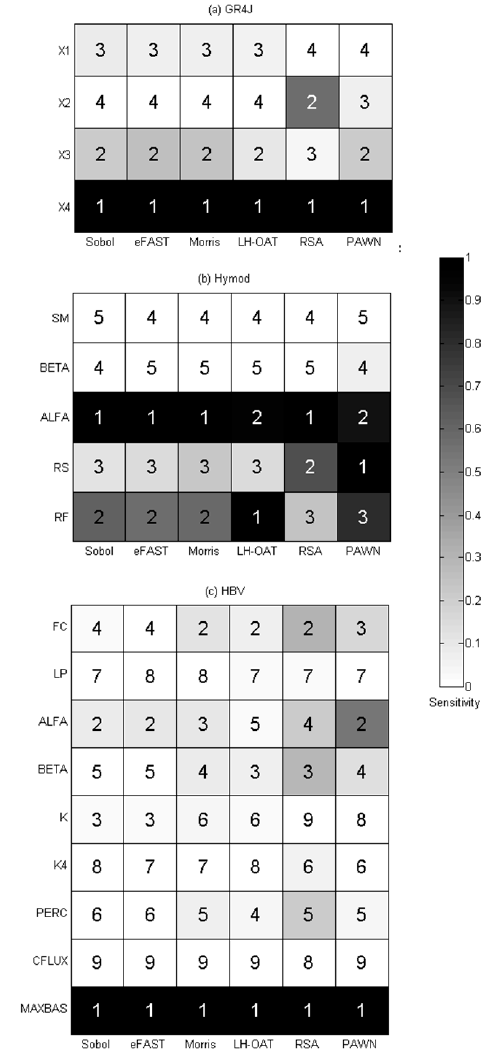
Figure 10. Sensitivity Indices (normalized) of six Sensitivity Analysis (SA) methods with benchmark run for GR4J ( a ), Hymod ( b ) and HBV ( c ) model, the number in the grid indicates the rank of the parameter within each SA method.